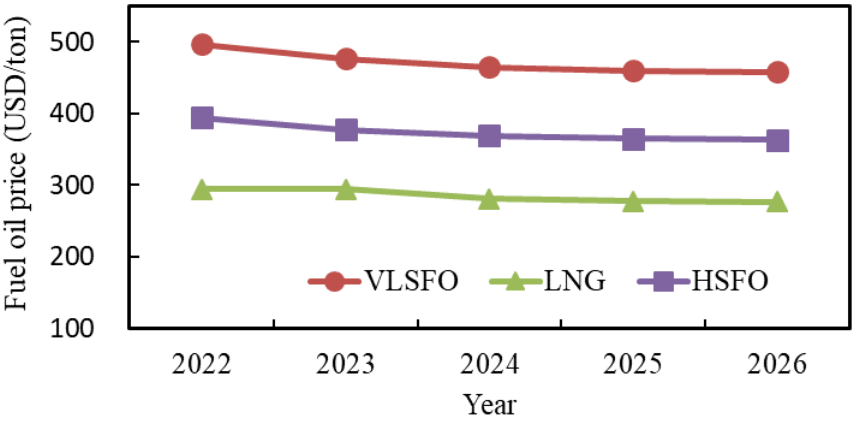
Figure 2. Estimated fuel prices for the next five years. Source: Compiled by the authors from [43,44].